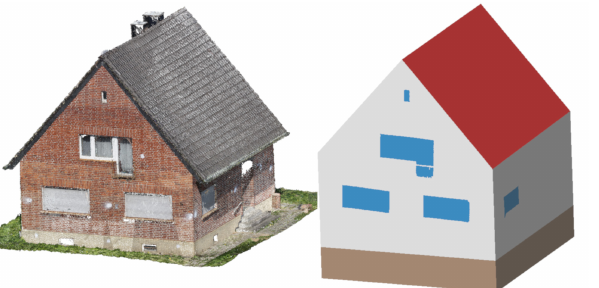
Figure 2. Point cloud of the case study building ( left ) and visualisation of its Python object model representation after adding the basement ( right